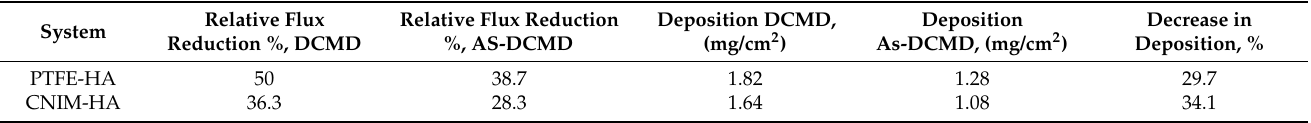
Figure 9. Scanning electron micrograph of membranes and fouling layer. ( a ) Pristine PTFE membrane. ( b ) Humic acid layer over PTFE. ( c ) Thin layer of humic acid in air sparging MD. ( d ) Carbon nanotube immobilized membrane (CNIM). ( e ) Broken humic acid layer over the CNIM membrane. ( f ) Cleaned CNIM surface with air sparging. Table 1. Fouling deposition and relative reduction in flux for PTFE and CNIM membrane.